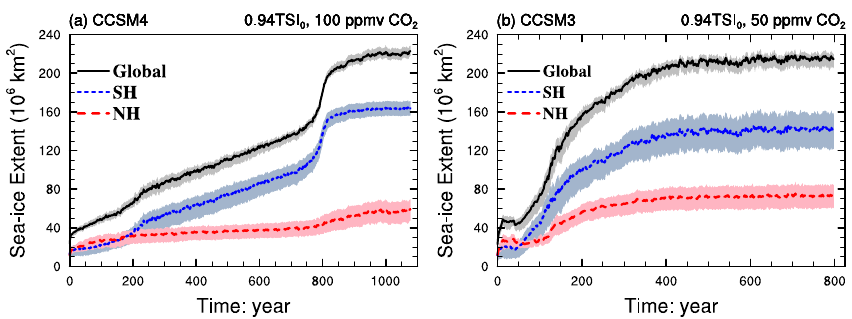
Fig. 8. CCSM4 (a) vs. CCSM3 (b) : sea ice evolution in the Northern Hemisphere (NH, red line), in the Southern Hemisphere (SH, blue line) and for total (Global, black line). Shaded area shows the range of the seasonal cycle. Note: the ocean area is 205 × 10 6 km 2 in the SH and